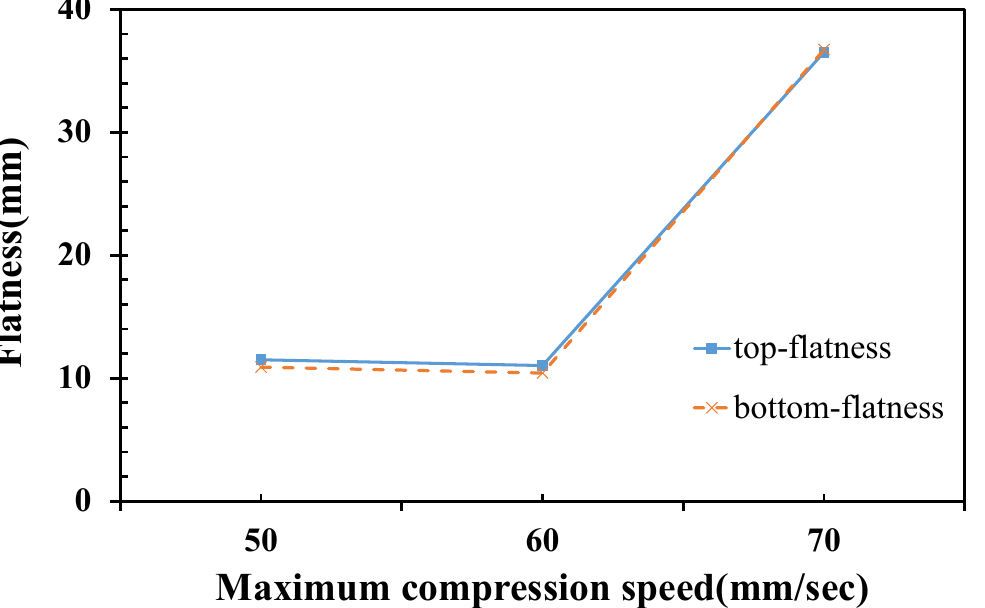
Figure 7. Numerical flatness with respect to the maximum compression speed for an HDPE half- pallet.